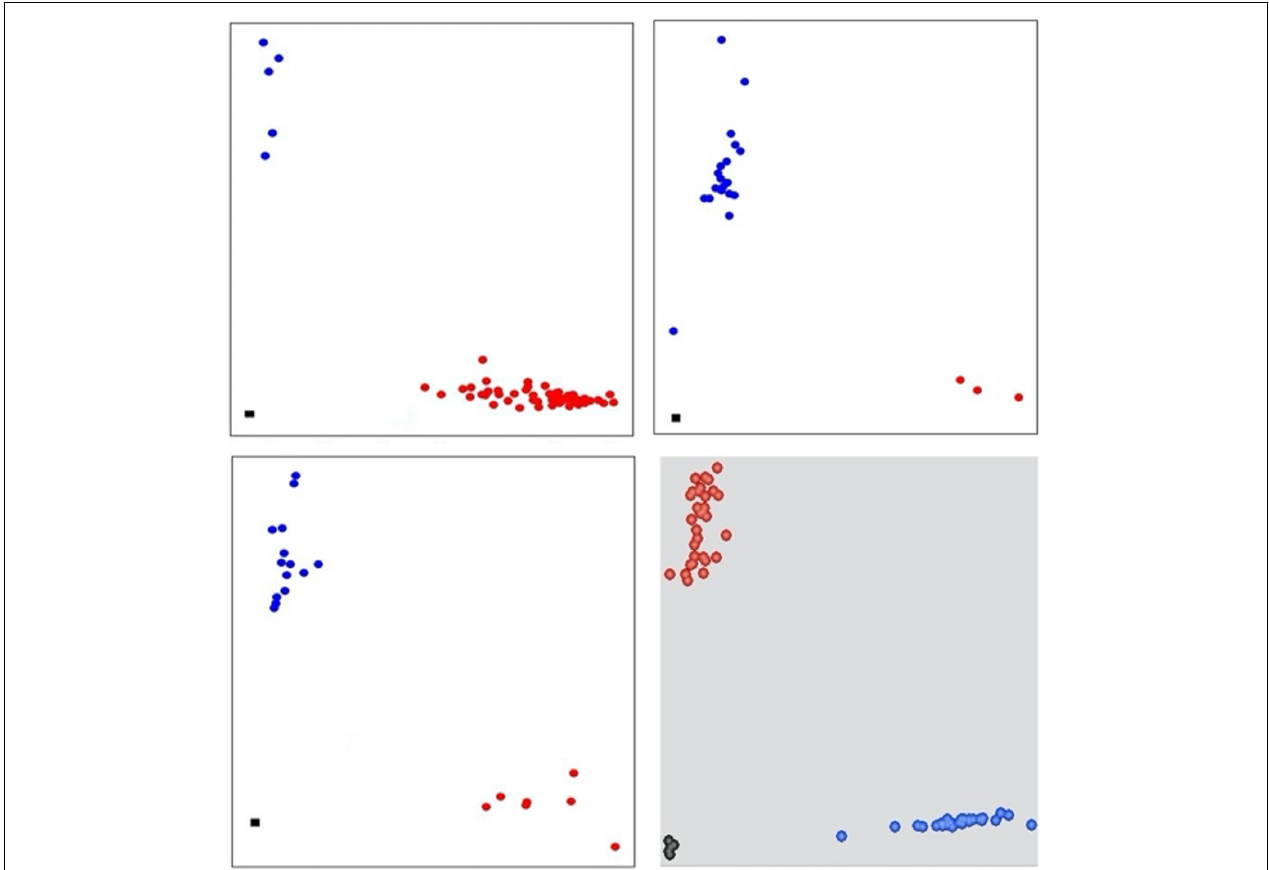
FIGURE 1 | Scatter plot for selected KASP assays showing clustering of genotypes on the Y - and X- axes. Genotypes colored red have a HEX-type allele; genotypes colored blue have a FAM-type allele; black dots represent non-template control. Top left and right corners, KASP assays for TaSnRK2.3 -1A and TaSnRK2.3 -1B, respectively. Bottom left and right corner, KASP assays for TaSAP -7B and TaLTPs , respectively.